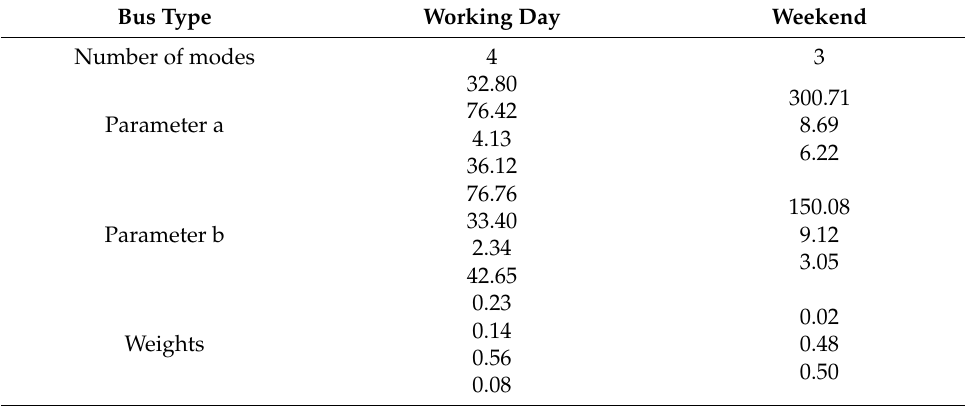
Figure 4. PDF for plug in time for: ( a ) Working day; ( b ) Weekend. Table 2. Parameters for BMM